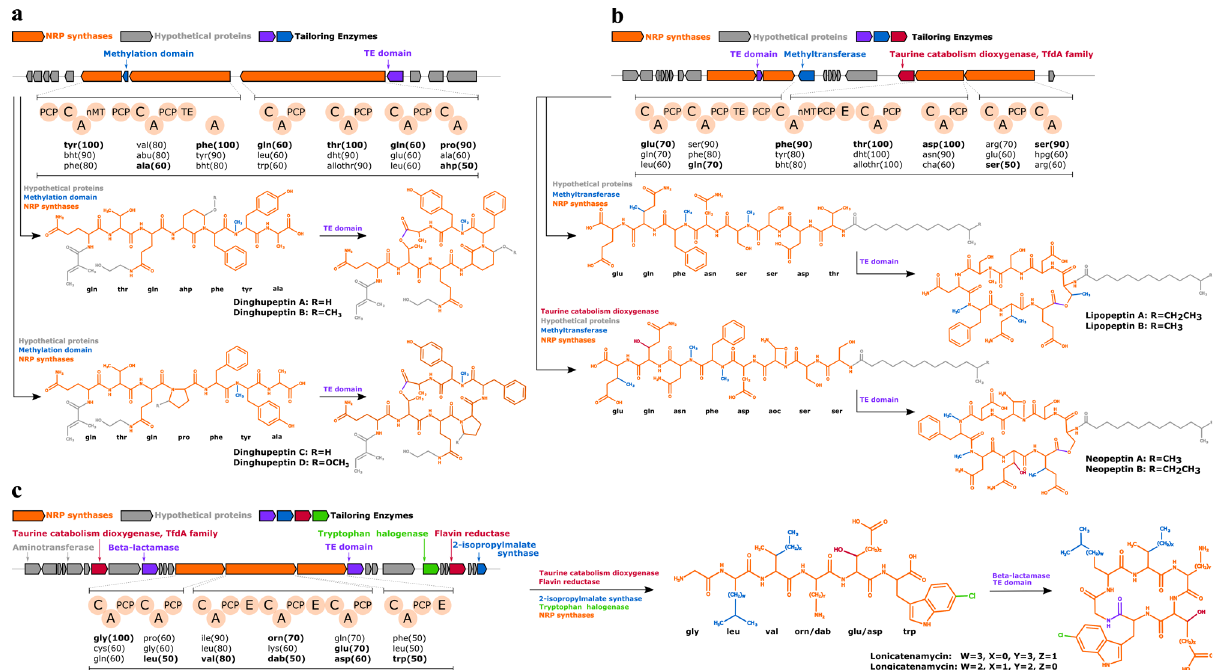
Fig. 7 Putative BGCs of three secondary metabolite families identi fi ed by molDiscovery. a dinghupeptin family in Streptomyces sp. NRRL B-5680, b lipopeptin and neopeptin family in S. hygroscopicus NRRL B-1477 and c longicatenamycin family in S. rimosus NRRL B-8076. MolDiscovery identi fi ed four dinghupeptin variants, two lipopeptin variants, neopeptin variants and two longicatenamycin variants at FDR 0%. After searching the corresponding genomes using antiSMASH, we detected NRP BGC with adenylation domains which show high speci fi city to the amino acids residues of these families. We also used DFAST (Supplementary Table 6 – 8) and HMMsearch to annotate the genes in the gene cluster. The post-modi fi cations and the corresponding putative tailoring enzymes are color coded. In the putative BGC of longicatenamycin family, it is known that hydroxylation (red) can be induced by the Taurine catabolism dioxygenase 57 , and fl avin reductase can involve in FAD-dependent hydroxylation 58 . 2-isopropylmalate synthase (blue) can function on the isopropyl group and elongate the chain (EC